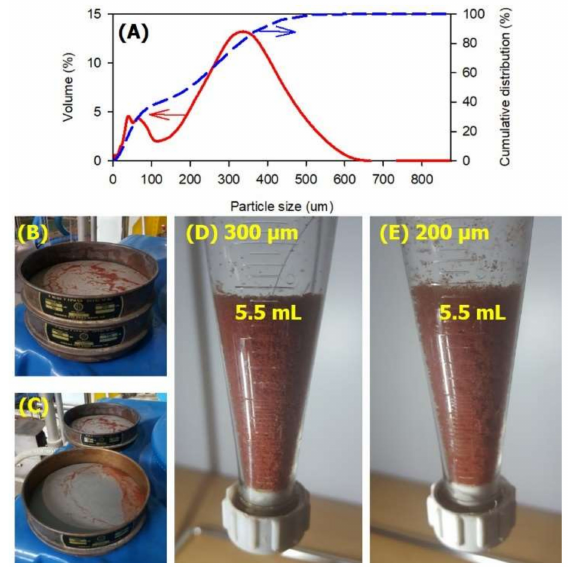
Figure 4. Size distribution of anammox sludge ( A ) and the sieve screening result ( B )-( E